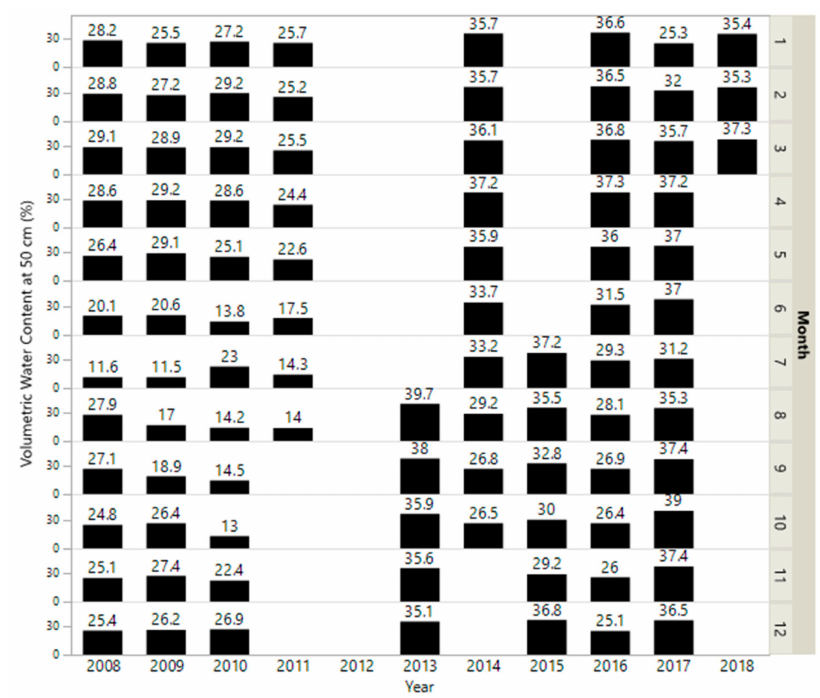
Figure A5. Monthly average volumetric water content (%) at 50 cm depth by year.